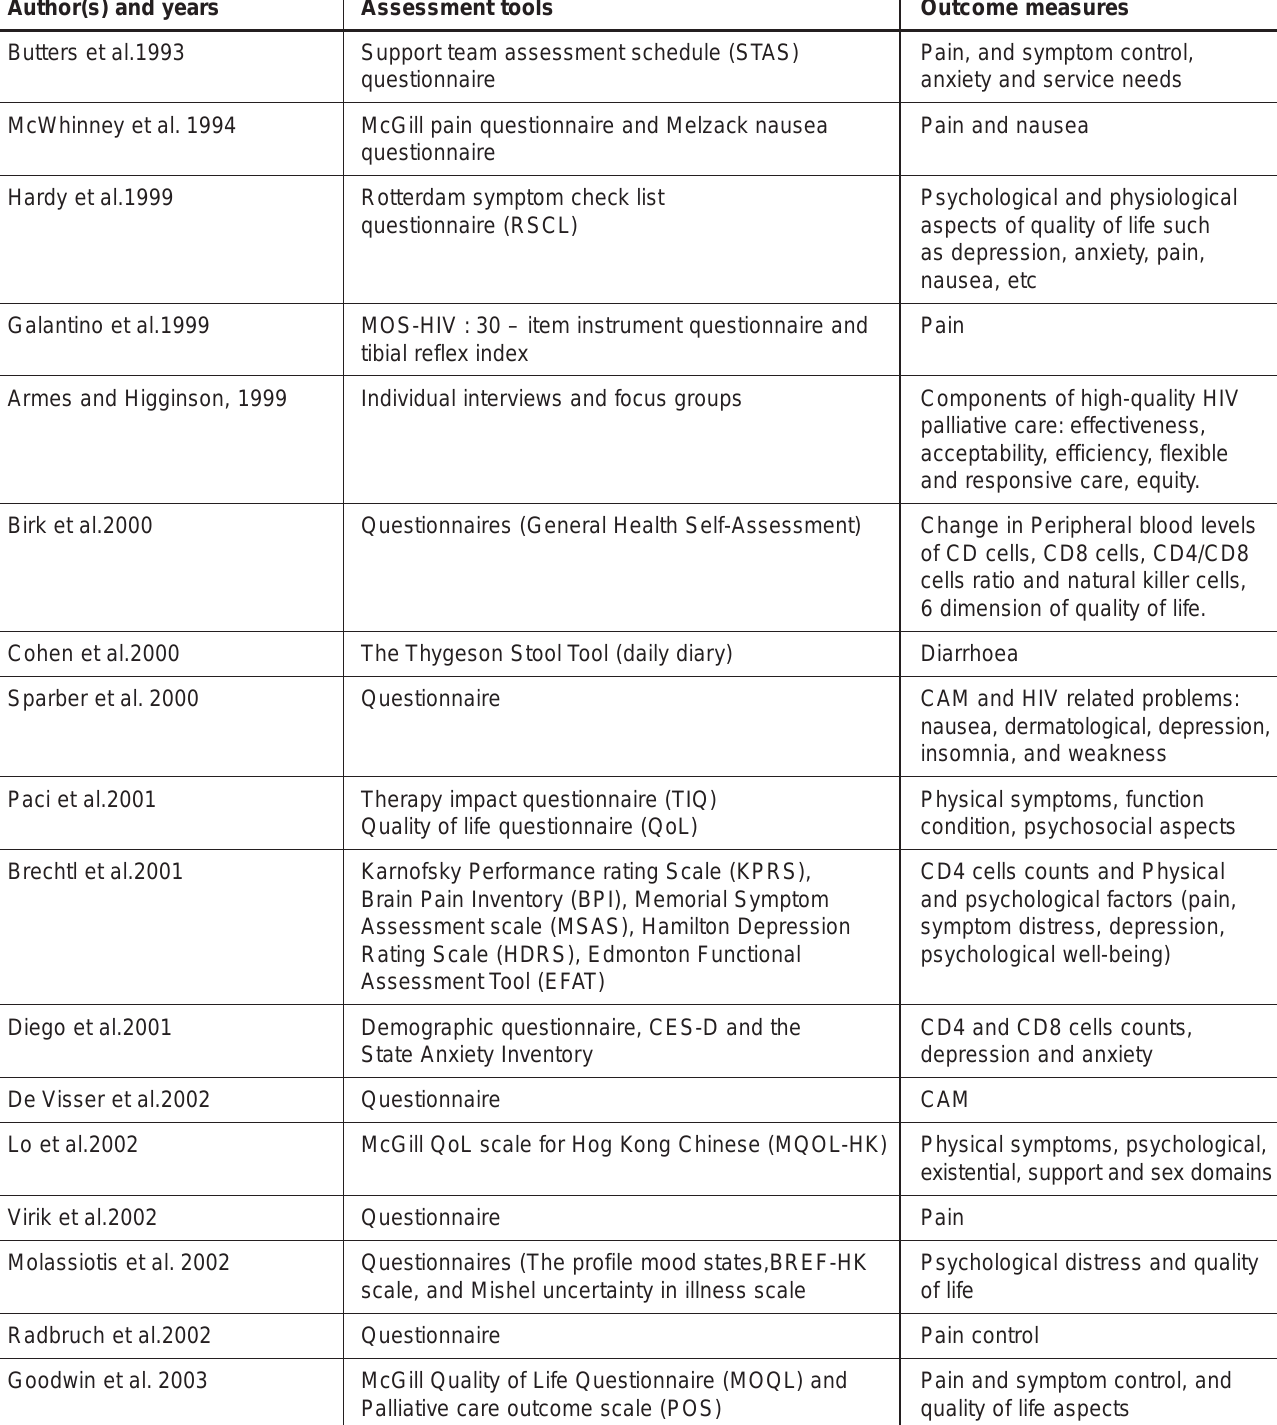
Table 11: Assessment Tools and Outcome